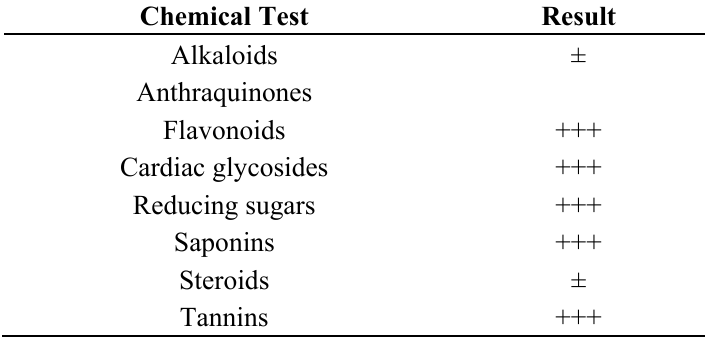
Table 1. Phytochemical screening of stem bark extract of Parkia biglobosa .